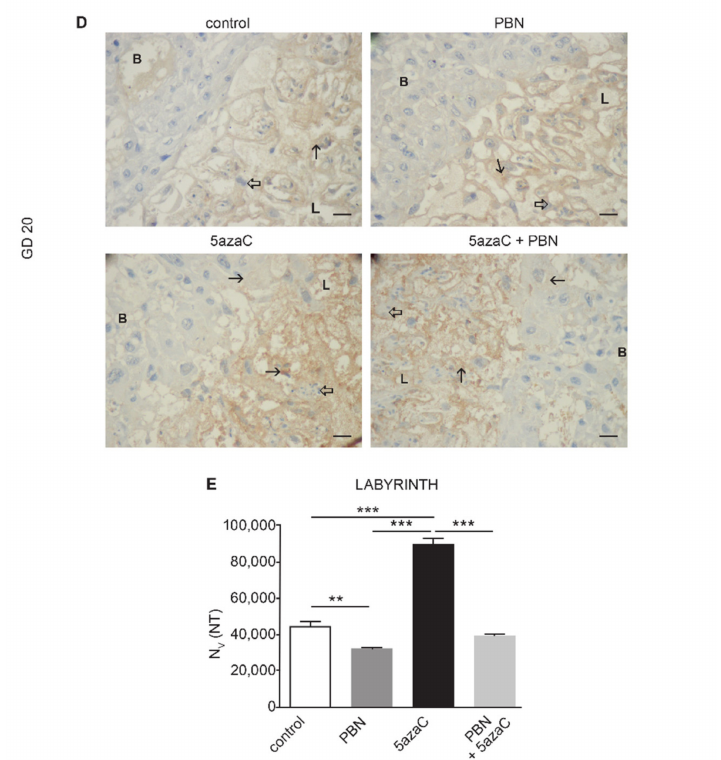
Figure 5. Nitrotyrosine (NT) expression in the placental labyrinth (L) and basal layer (B) treated with PBN and/or 5azaC on GD 12–13 and isolated on the GD 15 or GD 20. A, D Images of nitrotrosine expression (arrow) in placentas isolated on GD 15 ( A ) or GD 20 ( D ). Numerical density (Nv) of NT-positive signals in the labyrinth of GD 15 ( B ) and GD 20 ( E ) and GD 15-basal layer ( C ). Thick arrow–internal negative control. DAB, haematoxylin counterstain. Scale bar 25 µ m. ANOVA, ** p < 0.001, *** p <